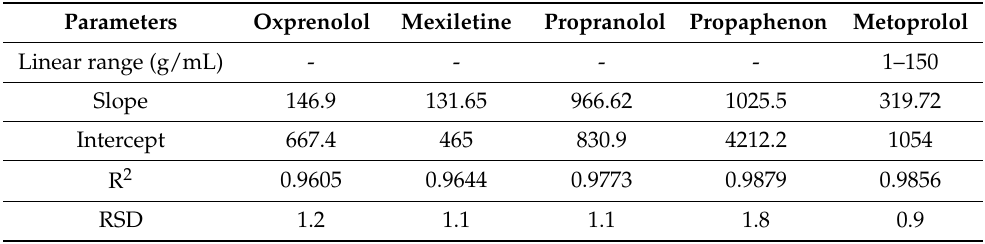
Table 1. Correlation coefficient and Linearity with relative standard deviations of extraction by PTh-coated SPME fibers from aqueous solutions ( n = 3) [46].